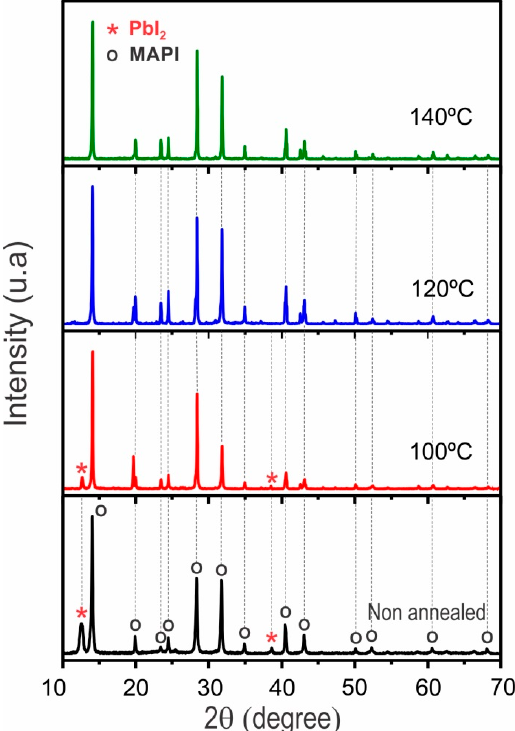
Figure 3. X-ray di ff raction (XRD) spectra of a MAPI film prepared under a PbI 2 / MAI thickness ratio Figure 3. X-ray diffraction (XRD) spectra of a MAPI film prepared under a PbI 2 /MAI thickness ratio of 3:1, followed by post deposition annealing in N 2 -atmosphere for 20 min at temperatures varying of 3:1, followed by post deposition annealing in N 2 -atmosphere for 20 minutes at temperatures between 20 and 140 ◦ varying between 20 and 140 °C.